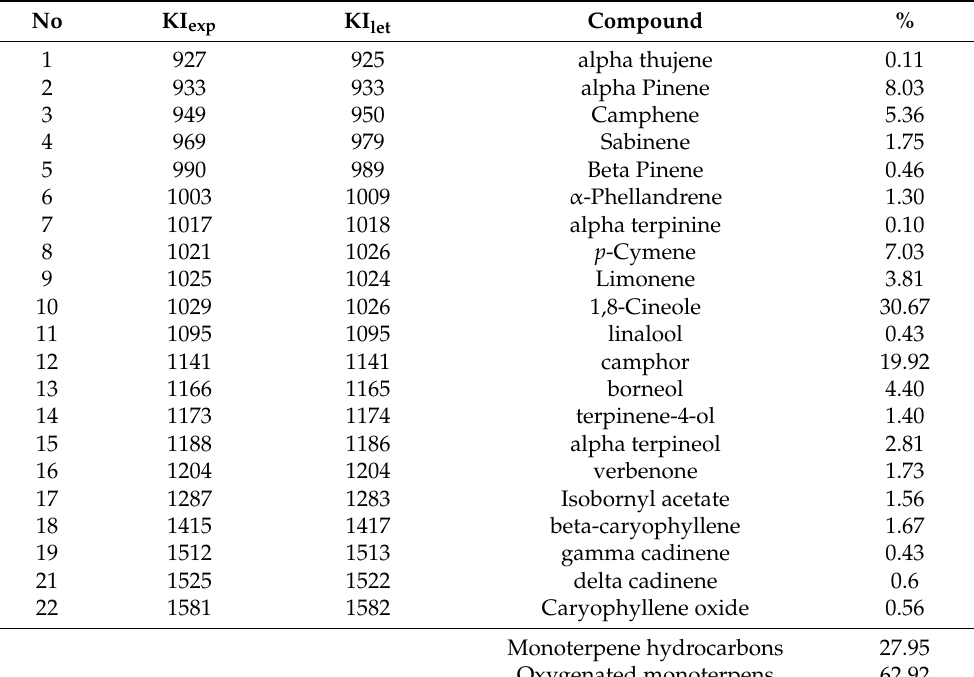
Table 2. Main chemical composition of Rosmarinus officinalis’ essential oil using GC/MS. KI exp : experimental kovats index; KI let : literature kovats index.